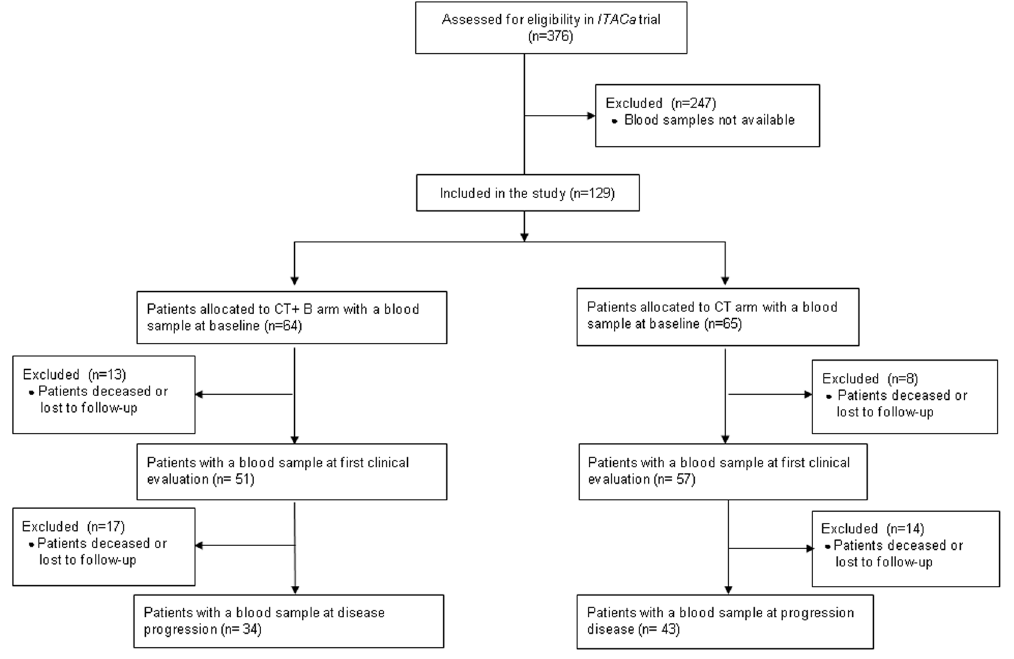
Figure 3. OS with respect to reduced eNOS or VEGF levels and reduced eNOS and VEGF levels in patients treated with CT + B (( A , C ) respectively) or CT (( B , D )